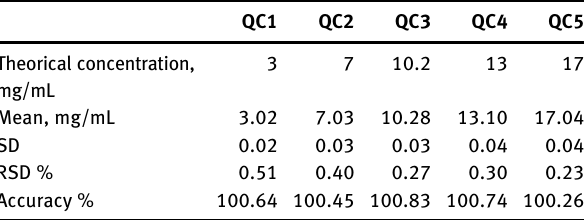
Table  : Interday repeatability of voriconazole stock